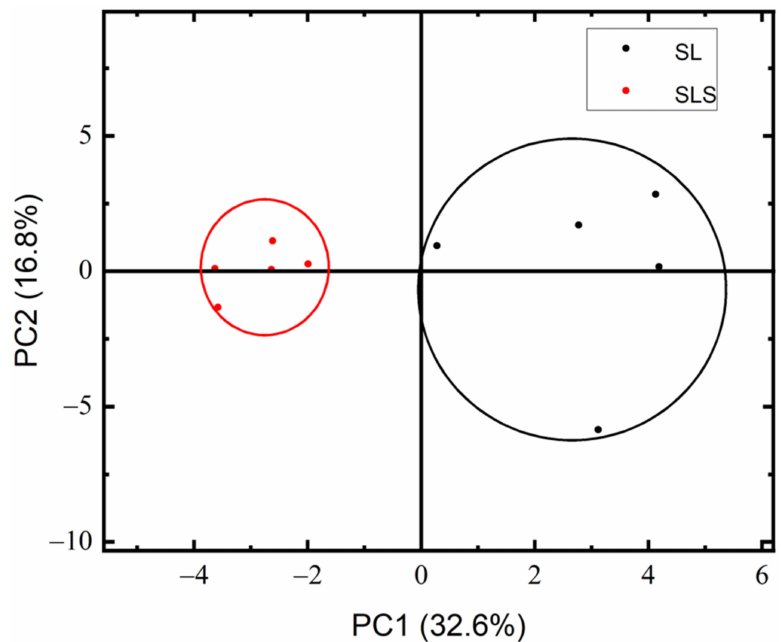
Figure 7. Principal component analysis of SERS spectra of SLS and SL. Red circle represents the region containing the data of saliva and S protein. Black circle represents the case of pure saliva.